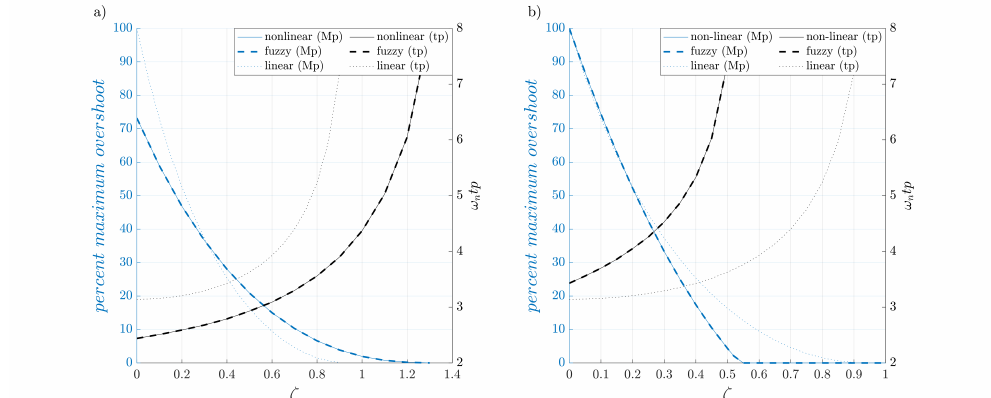
Figure 16. The result for concentration graphs shows the per cent overshoot and normalised peak time as a function of damping ratio ζ ; ( a ) step-up, ( b ) step-down.